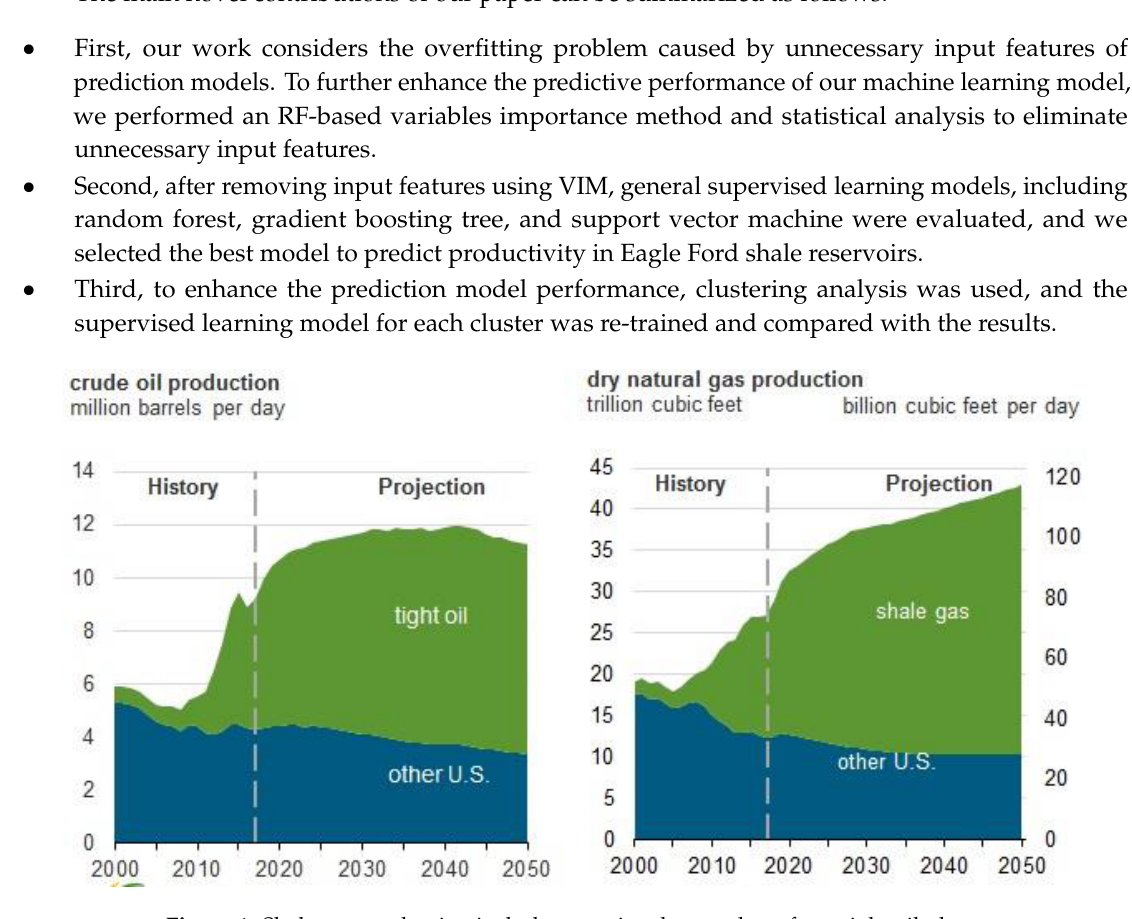
Figure 1. Shale gas production includes associated natural gas from tight oil plays.